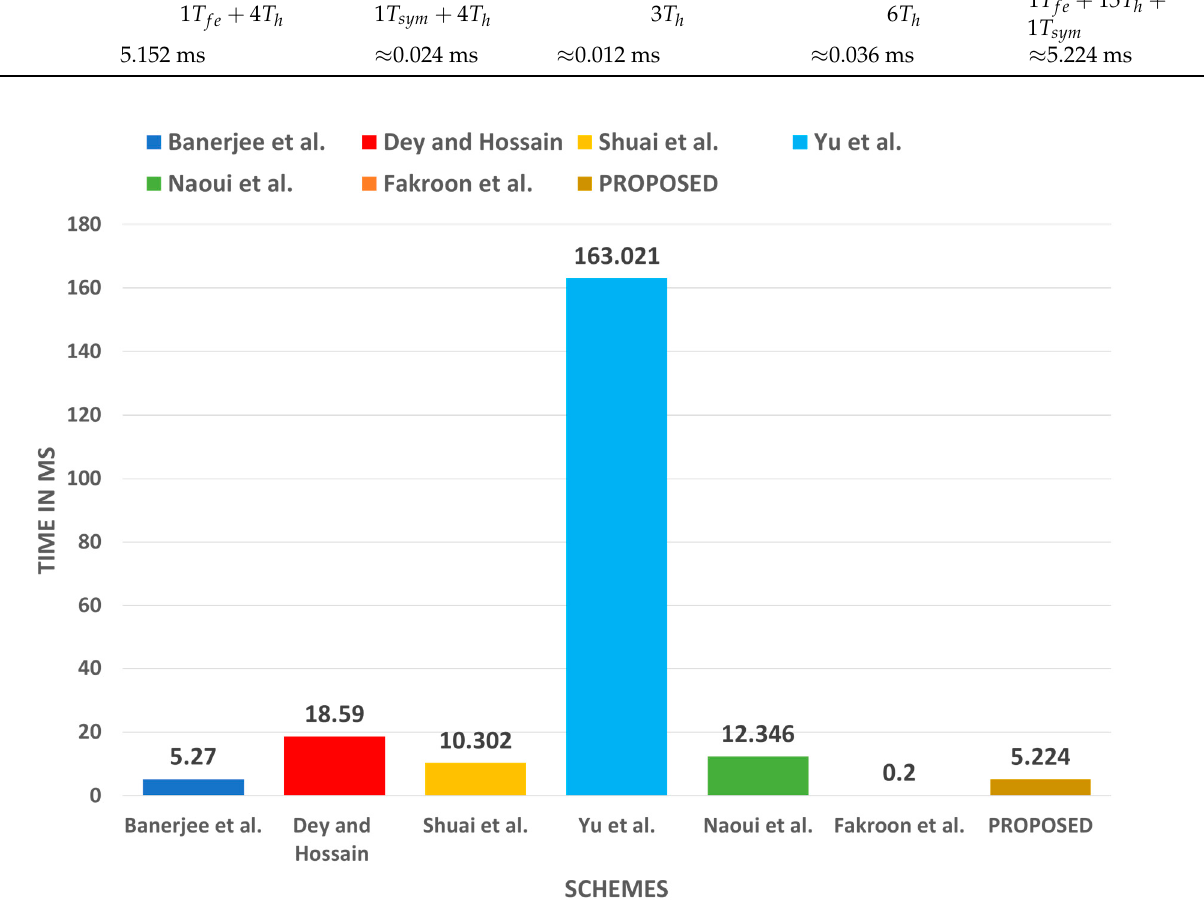
Figure 11. Computation cost